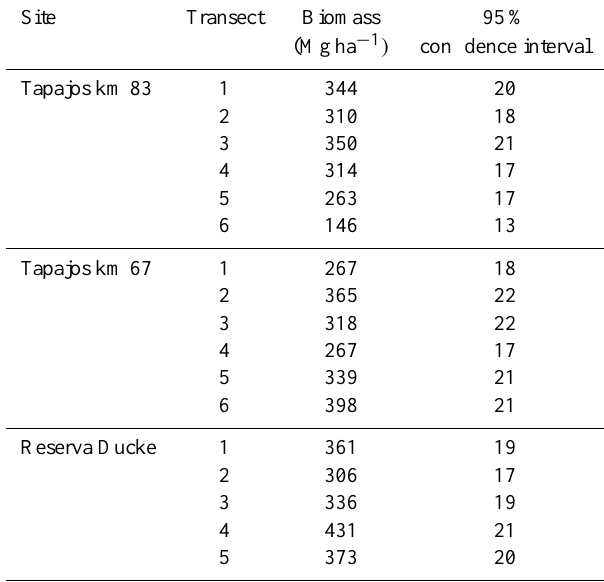
Table 4. Transect live biomass and 95% confidence interval due to height uncertainty as calculated using the Monte Carlo analysis described in Sect